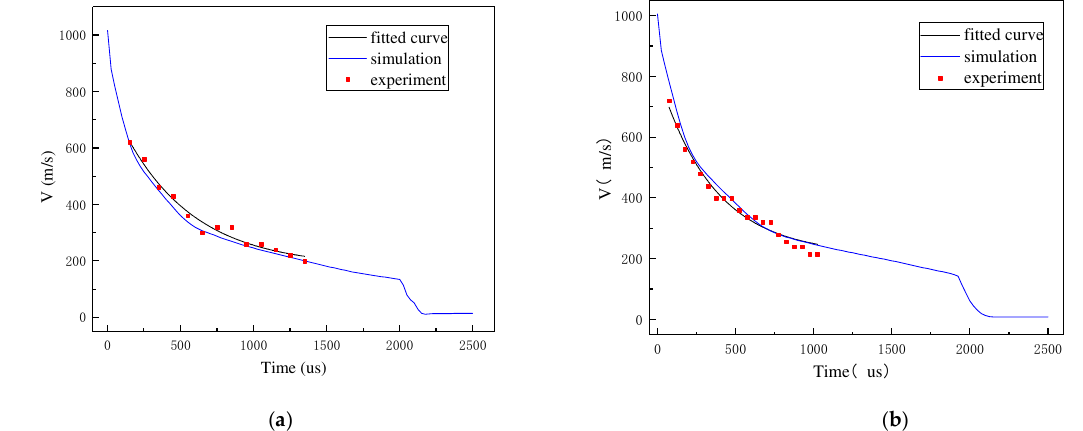
Figure 5. Comparison of tested and simulated velocities. ( a ) Test 1 velocity curve; ( b ) test 3 velocity curve.